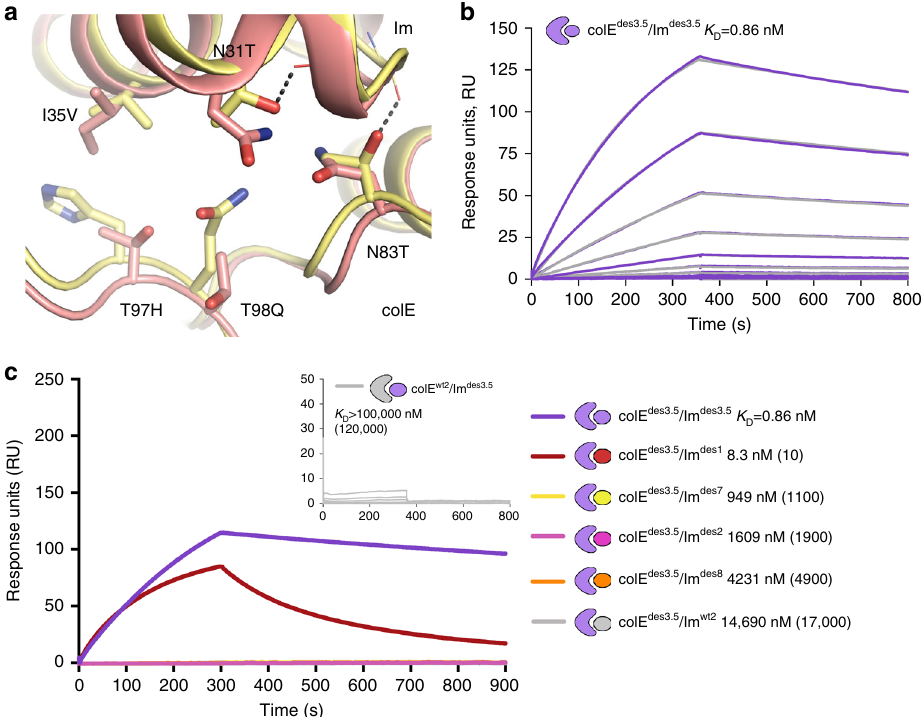
Fig. 5 Large gains in af fi nity and speci fi city using Af fi Lib af fi nity-enhancement design. a Low-energy combinations of mutations (sticks) were designed at the colE des3 /Im des3 interface. Model structure of the starting colE des3 /Im des3 pair and model of the higher-af fi nity colE des3.5 /Im des3.5 are shown in salmon and yellow, respectively. b SPR analysis for colE des3.5 /Im des3.5 shows cognate af fi nity of 0.86 nM (data in light purple; fi ts in gray), relative to 73 nM for colE des3 /Im des3 (Supplementary Fig. 3). K D was determined by fi tting to a single-exponential kinetic model ( k on = 4.15 × 10 5 M − 1 s − 1 , k off = 3.57 × 10 − 4 s − 1 ). c Improved pairwise speci fi city in colE des3.5 /Im des3.5 relative to the original design pair. colE des3.5 shows 10 – 10 4 -fold af fi nity difference between cognate (light purple) and non-cognate interactions (colE des3 pairwise speci fi city values in parentheses). The SPR sensograms were collected at 0.96 nM Im concentrations. Inset: Im des3.5 shows no detectable binding to colE wt2 in concentrations up to 56.7 μ M, translating to a pairwise speci fi city switch of 10 5